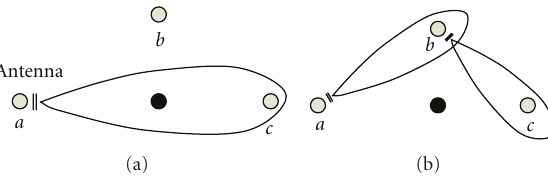
Figure 7: An illustration of using directional antennas to bypass a detection